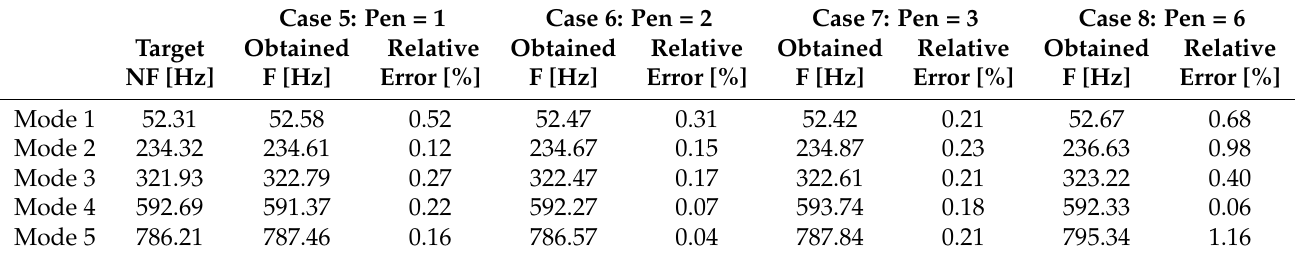
Table 6. Comparison between the target frequencies and obtained ones for Cases 5, 6, 7 and 8. F denotes frequency. The errors are relative to the